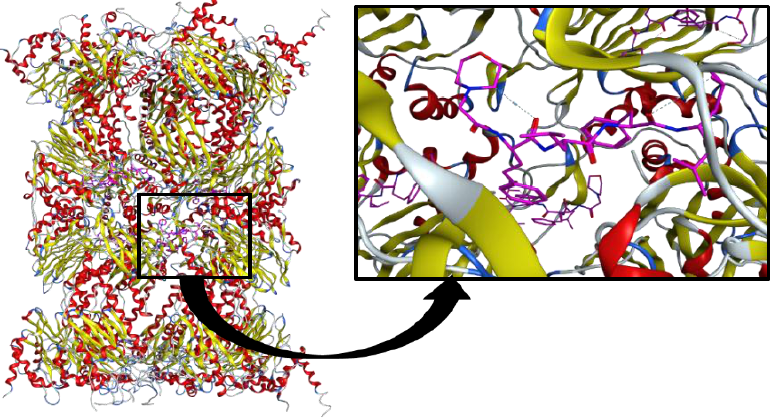
Figure 2. Crystallographic structure of the human constitutive 20S proteasome complexed with carfilzomib (pink) at 2.6 Å resolution (PDB ID: 4R67).